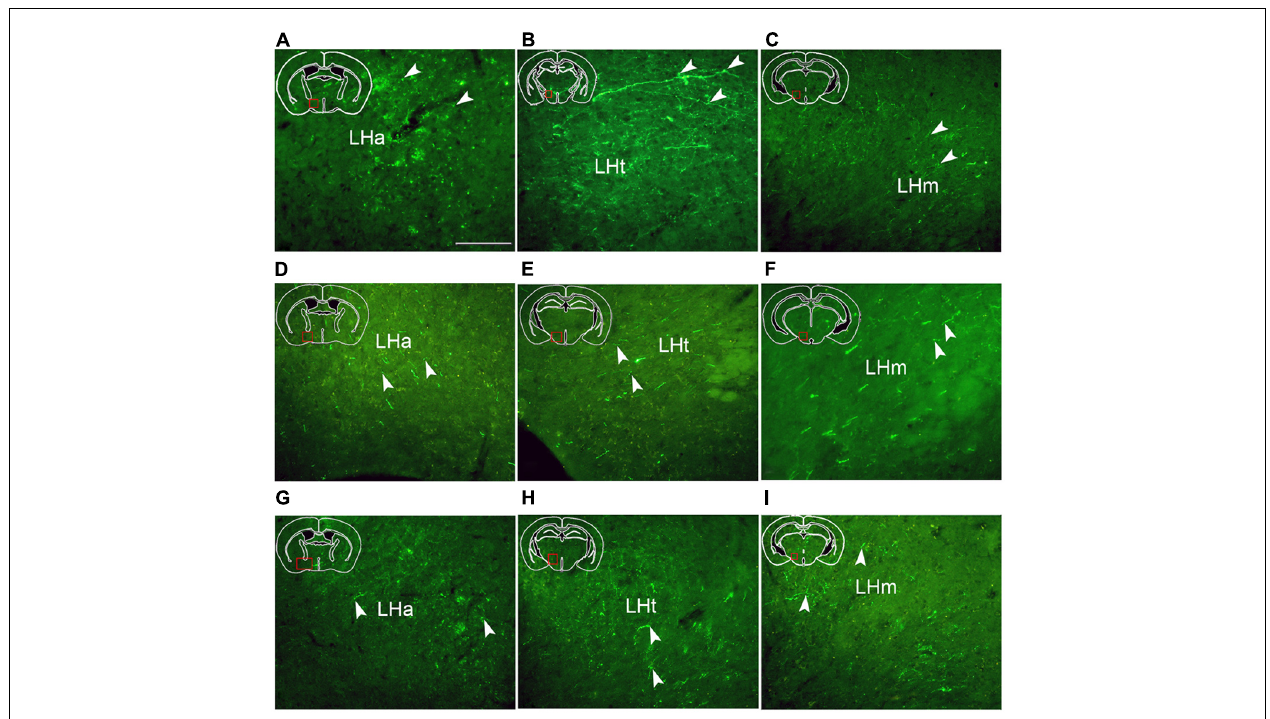
FIGURE 6 | Fluorescent images demonstrating hrGFP-IR axons and termini from the AcbC (A,B,C; M-7), the medial AcbSh (D,E,F; M-11), and the ventral AcbSh (G,H,I; M-21). Axons invade the anterior part of lateral hypothalamus (LHa), the tuberal part of